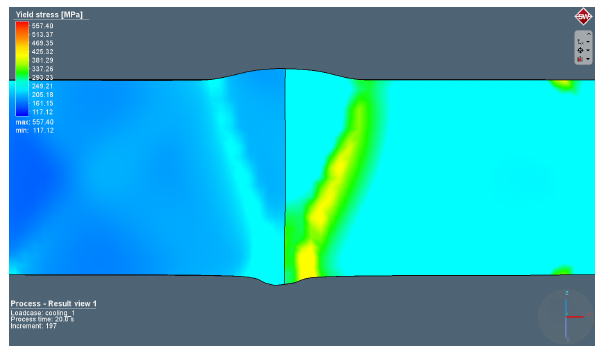
Figure 5: Yield stress distribution of simulated laser welded joint in cross section